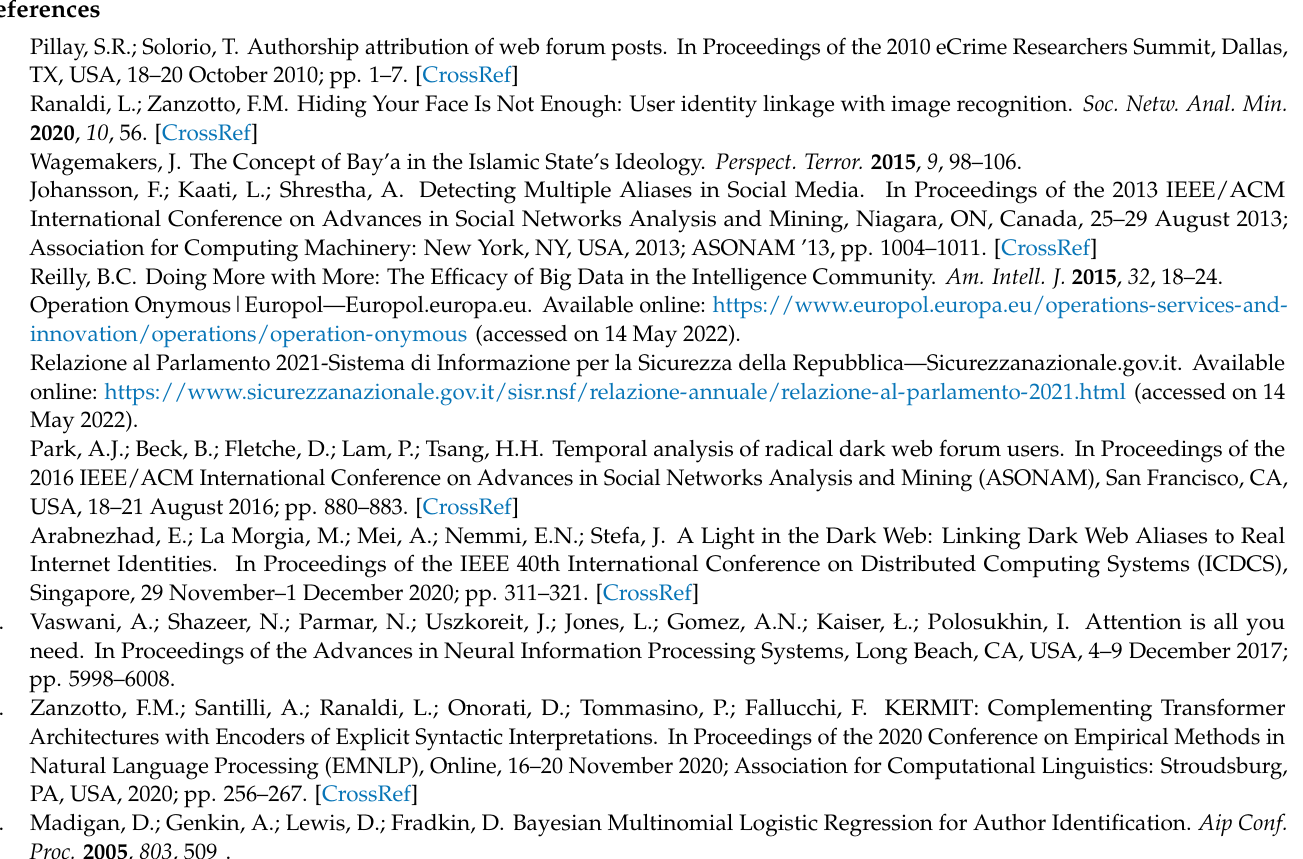
Figure A1. Confusion matrices of the top two models for each subtask. At the top are the confusion matrices for TFIDF+POS-tag-based models, at the bottom are the confusion matrices for BOW+POS- tag-based models.The authors were anonymized with the name “Member